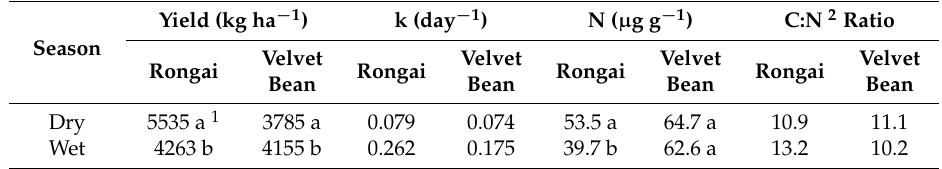
Table 1. Average values of yield, k constant, N concentration and C:N ratio for the interaction of season and cover crops species growing in an Oxisol in the Agricultural Experiment Substation of Isabela, Puerto